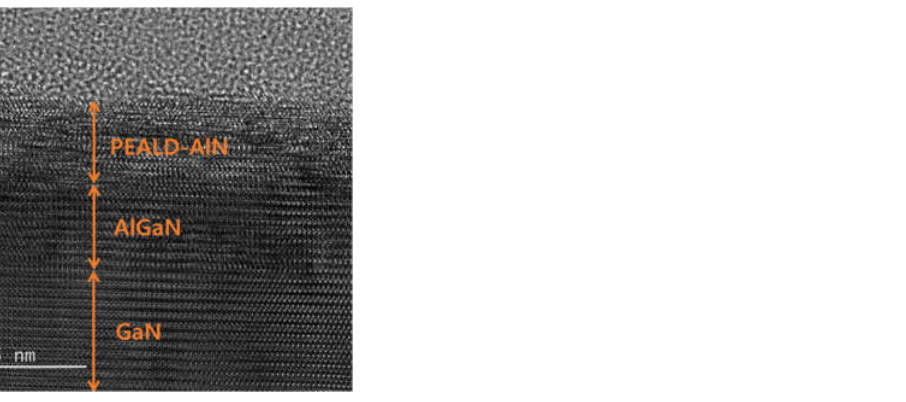
Figure 3. Cross-sectional HRTEM image of PEALD AlN film deposited on AlGaN/GaN heterostructure. In Figure 4, the results of the TEM energy-dispersive X-ray spectroscopy (TEM-EDX) mapping of the PEALD-deposited AlN film on the AlGaN/GaN structure are displayed.